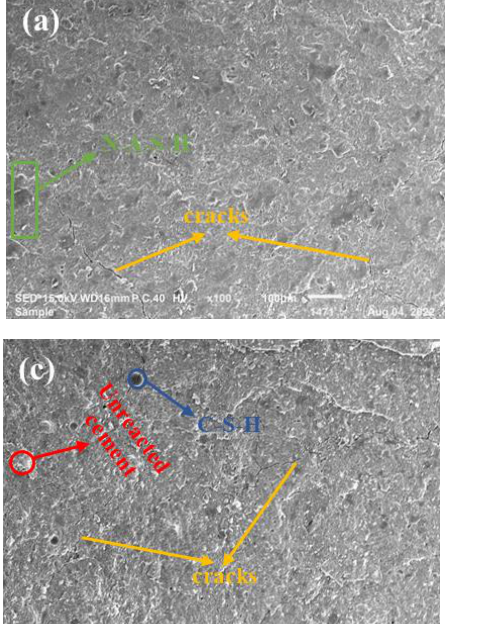
7 of 12 Figure 4. Flexural strength of geopolymers containing different proportions of CEM I. 3.3. SEM Analysis Figure 5 presents the micro-morphologies of the geopolymers containing different proportions of CEM I. The microstructure of G 0 was relatively dense, and only a few mi- crocracks were visible, as can be seen in Figure 5a. Additionally, the geopolymerization of alkali-activated materials resulted in sodium aluminate silicate gels with a strong cross- linked molecular structure formed in the geopolymers, which was the cause of the speci- mens ’ dense internal structure. With the incorporation of CEM I, the hydration reaction of cement also occurred, and the calcium-based hydrated product (C-S-H) was formed in the specimens, as can be seen in Figure 5a – d. The coexistence of C-S-H and the geopoly- mer product N-A-S-H was found in Figure 5b. Additionally, the coexistence of C-S-H and N-A-S-H could effectively improve the mechanical properties of the specimens [26], con- sistent with the former results of the mechanical properties.